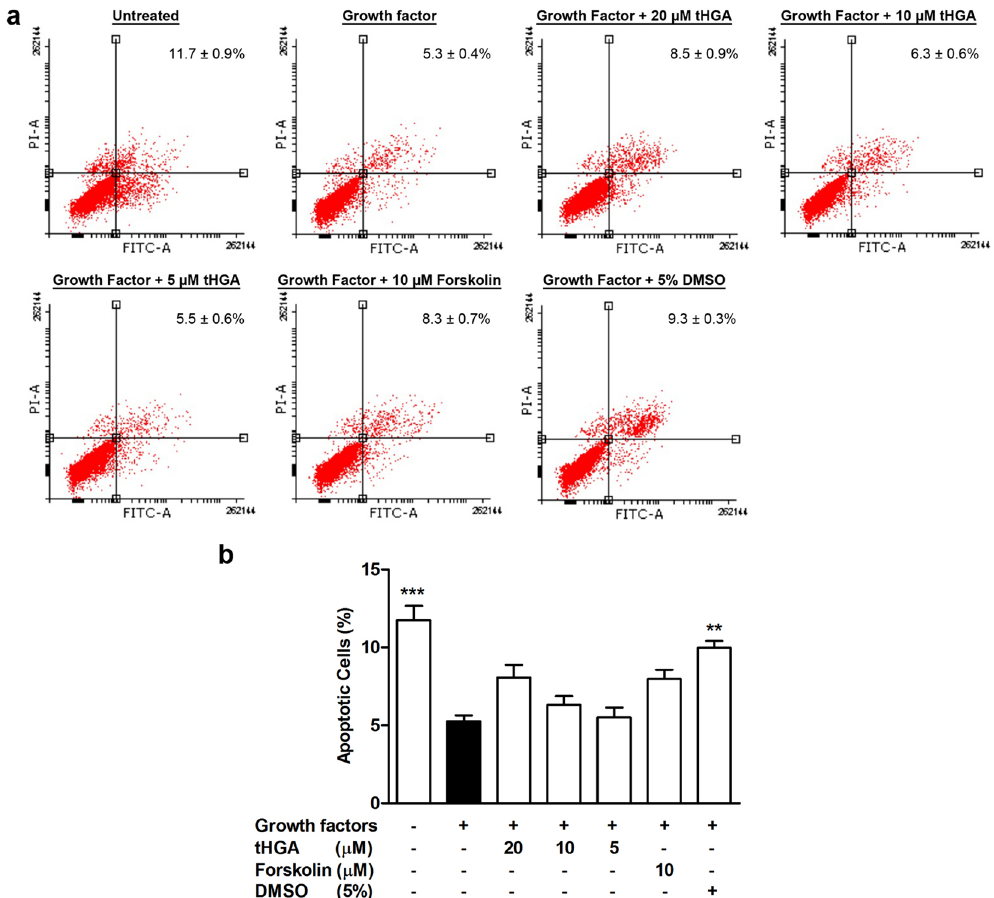
Figure 3. tHGA attenuates growth factor-induced hBSMC proliferation without inducing apoptosis. ( a ) Representative dot plots of Annexin V and PI flow cytometry apoptosis analysis on growth factor-induced hBSMCs upon tHGA or forskolin treatment. ( b ) Percentage of apoptotic hBSMCs upon tHGA or forskolin treatment. Results are presented as mean ± SEM of 3 independent experiments. * P < 0.05, ** P < 0.01 and *** P < 0.001, significantly different from growth factor-induced hBSMCs. GF: Growth factor; Fsk: